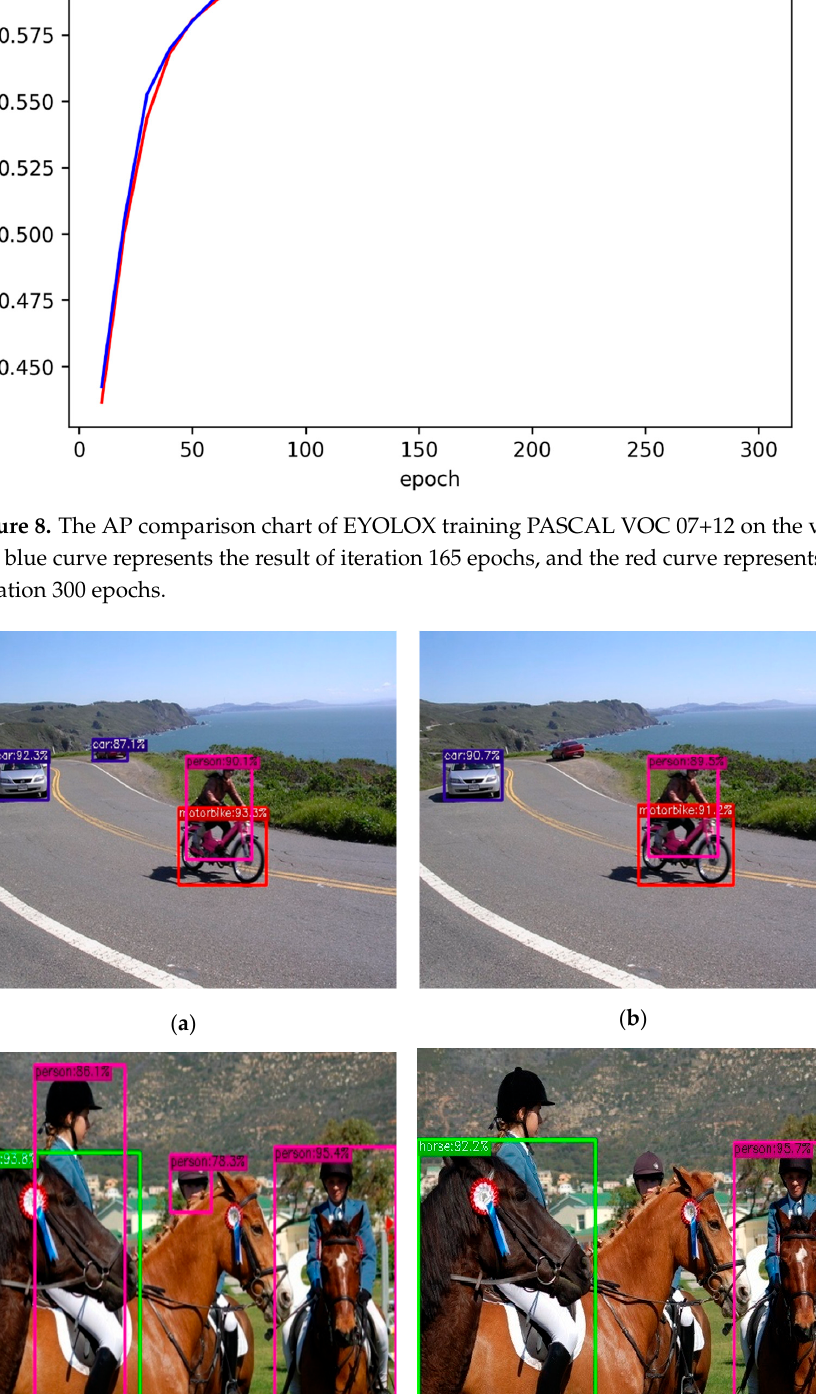
Figure 9. Comparison of the prediction results between EYOLOX ( a , c ), YOLOX-s ( b ) and YOLOv5-s ( d ).